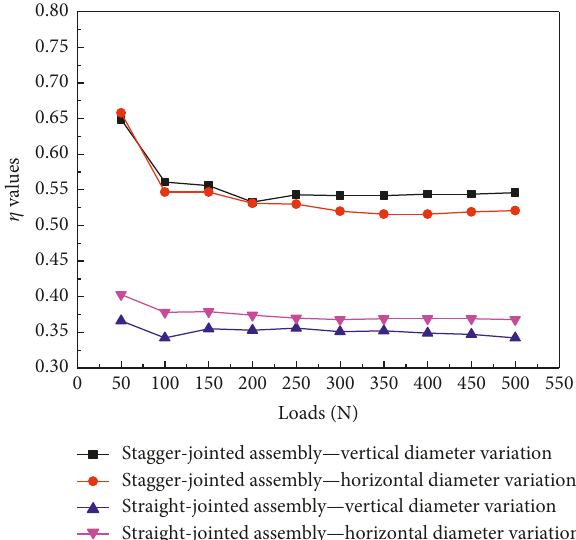
Figure 9: Relationships between the η values and the loads under the concentrated loading